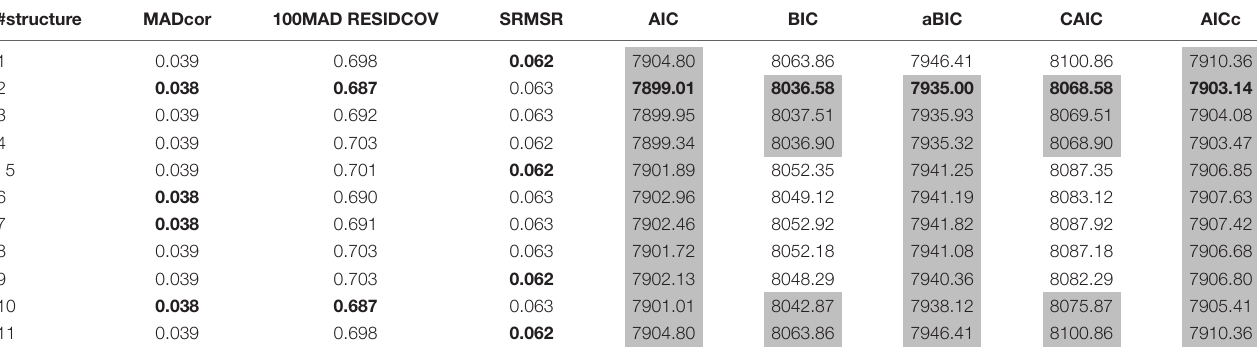
TABLE 11 | Model fit indices of SH-GDINA models for TIMSS data.